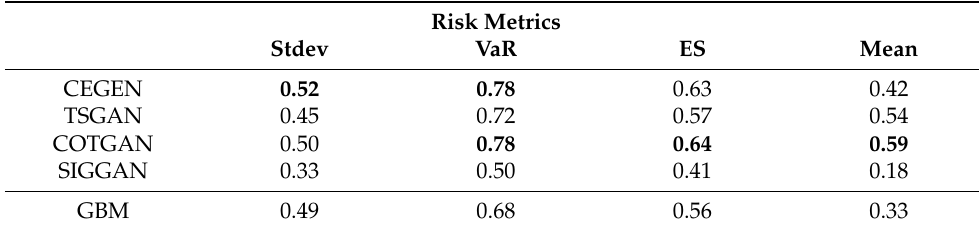
Table 4. Hedging effectiveness of at-the-money call option on spread. Bold values indicate best scores.